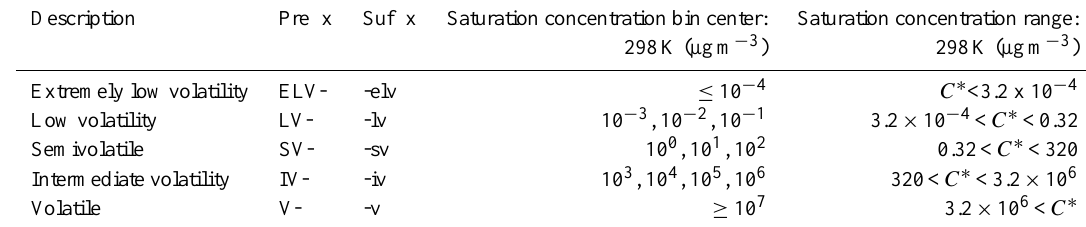
Table 4. Prefixes and suffixes used for identifying current and emitted volatility,